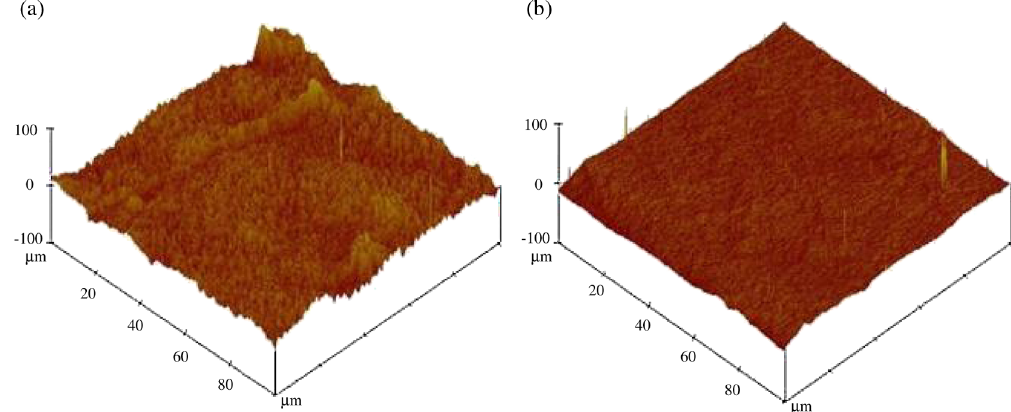
FIG. 10. AFM scans of single crystal sample 13 in Table I: (a) as received and (b) after 30 (cid:1) m removal by BCP. The horizontal scale is 100 (cid:1) m by 100 (cid:1) m ; the vertical scale is 100 nm.